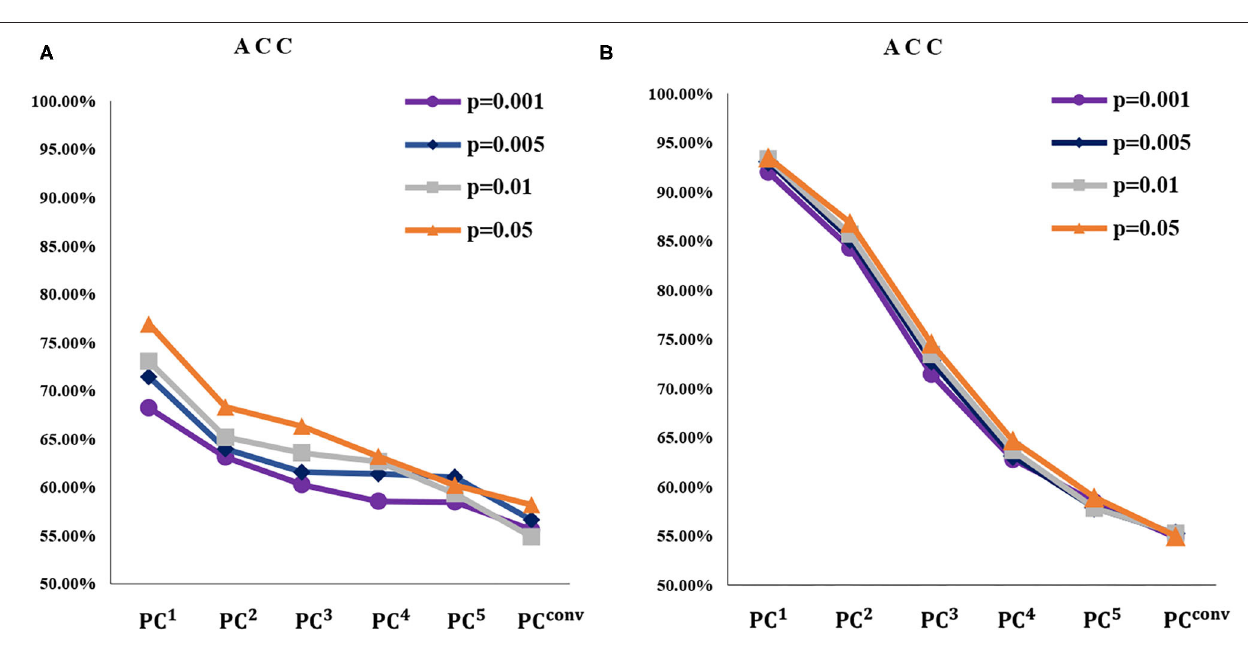
FIGURE 6 | The ACC of (A) MCI identification and (B) gender prediction based on BFNs with six different orders and four different p -values (for filtering features). The PC conv -based BFN is the empirically convergent adjacency matrix through thirty iterations. Note that, with the increase of n , the ACC of PC n -based BFN tends to decrease in all the